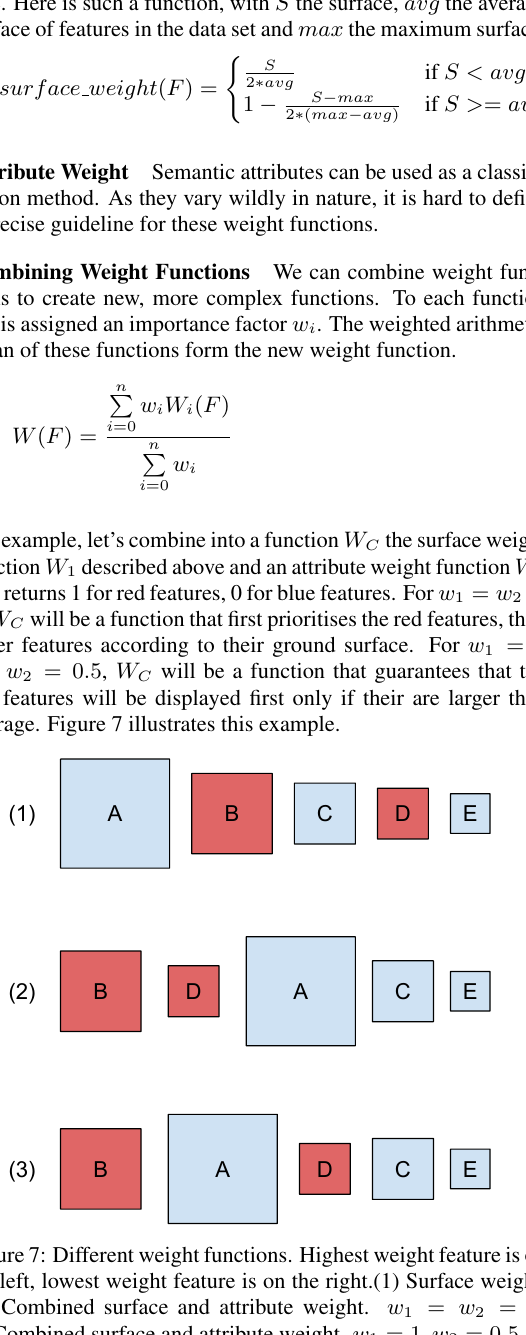
Figure 8: Screenshot of our web application based on Cesium. Buildings in red belong to level 0 tiles, those in orange to level 1 tiles, those in yellow to level 2 tiles and those in green to level 3